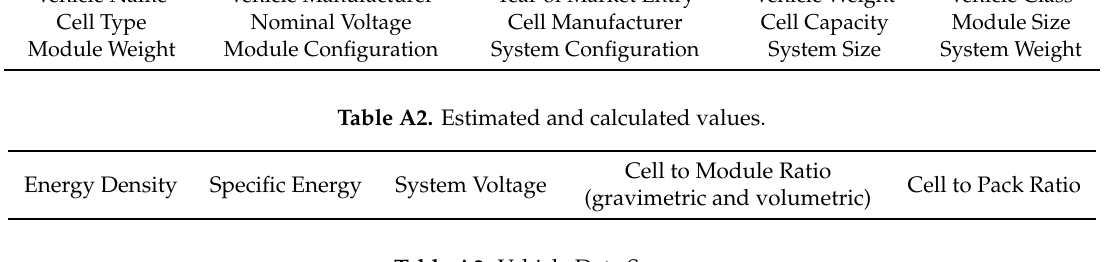
Table A3. Vehicle Data